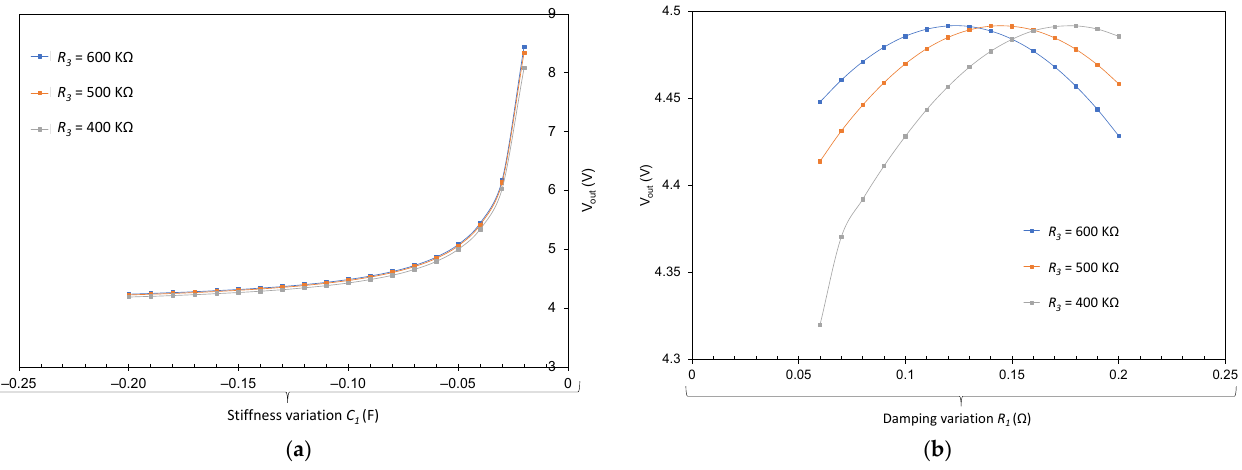
Figure 8. Output RMS voltage obtained in a resistance load situations and high coupled system: ( a ) for stiffness variations, ( b ) for damping variations.